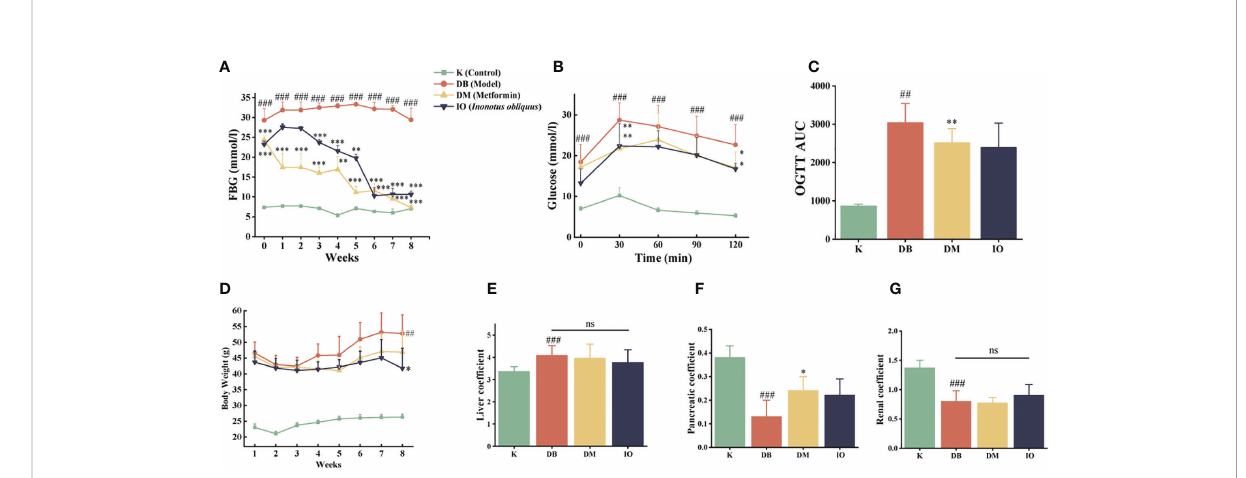
FIGURE 1 In fl uence of blood glucose utilization and organ coef fi cient Inonotus obliquus and metformin reduced blood glucose in db/db mice during the intervention period. FBG (A) and OGTT (B, C) . Inonotus obliquus and metformin exerted a weight loss effect (D) . Inonotus obliquus and metformin on liver coef fi cient (E) , pancreatic coef fi cient (F) and renal coef fi cient (G) in db/db mice. Data were expressed as the mean ± SD. ## p < 0.01 vs. K, ### p < 0.001 vs. K, * p < 0.05 vs.DB, ** p < 0.01vs. DB, *** p < 0.001vs.